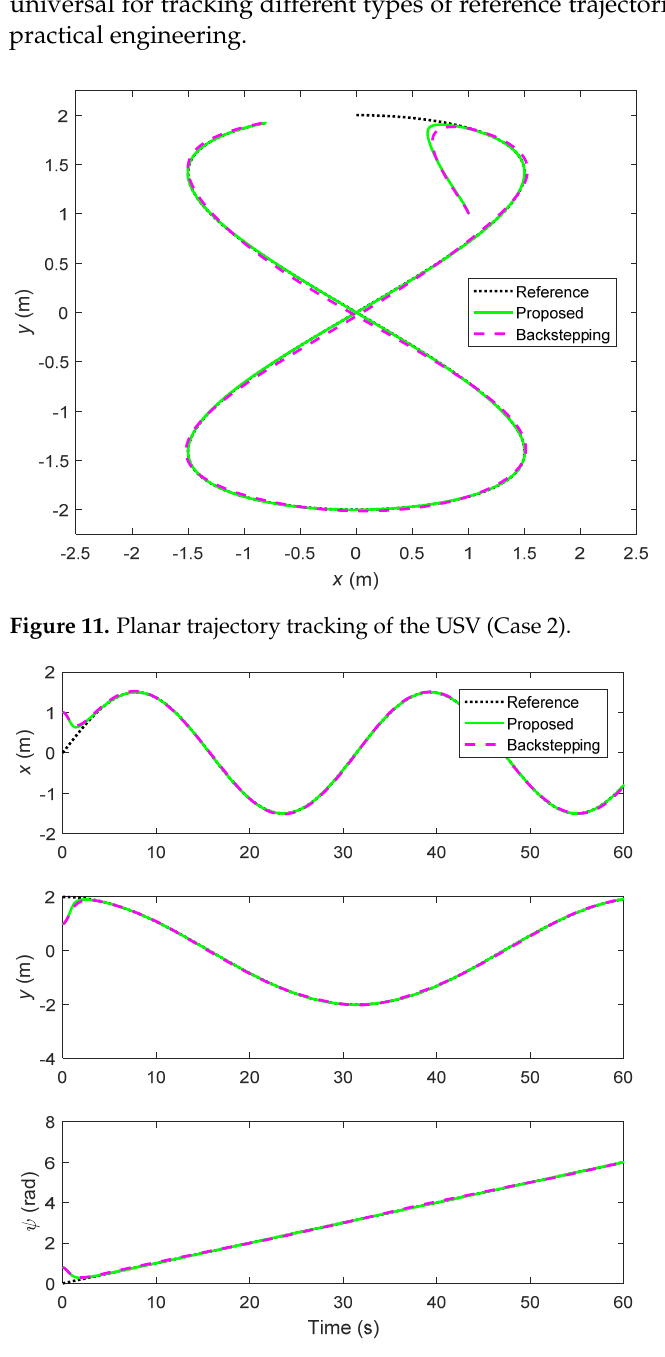
Figure 12. Pro fi le of the position tracking (Case 2).